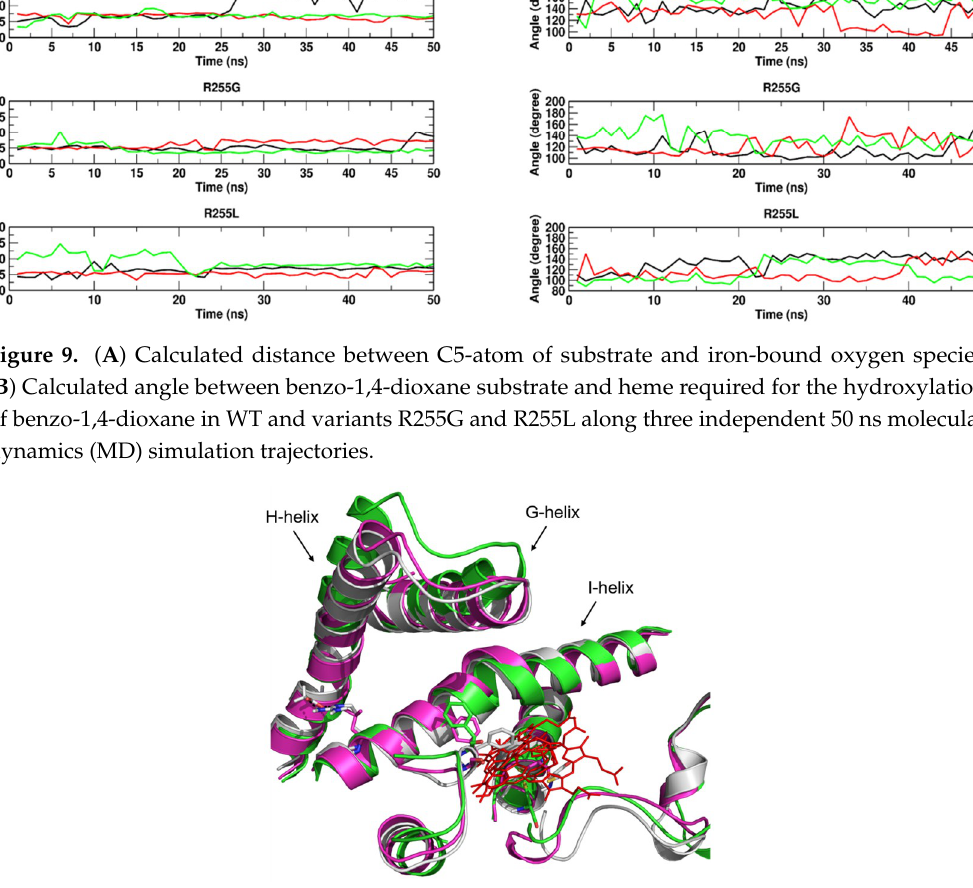
Figure 10. Cartoon representation of the structural alignment of P450 BM3 WT (grey) and P450 BM3 variants (R255G in green and R255L in magenta). Heme is depicted in red lines and residue F87 in sticks. A substantial rearrangement of the G-, H-, and I-helixes is observed. The models of the P450 BM3 variants R255G and R255L were constructed using the swap function in YASARA Structure Version 17.4.17 and optimized using the SCWRL rotamer library search for the designated substitutions.